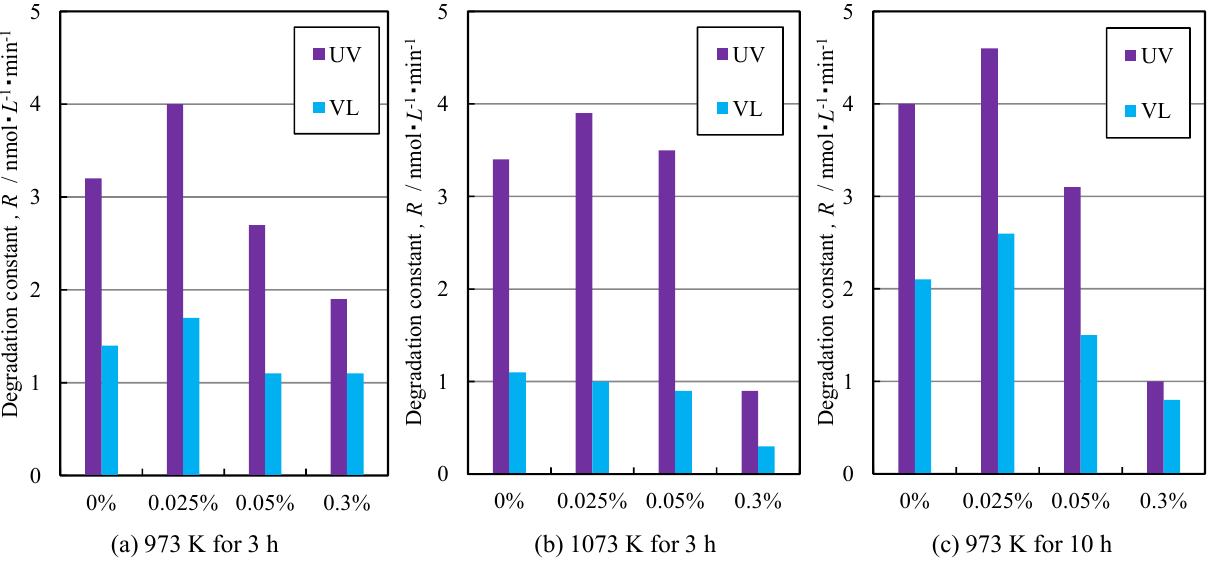
Figure 7. Degradation rate constant of M10- x Cr- y K samples. ( a ) 973 K for 3 h; ( b ) 1073 K for 3 h; ( c ) 973 K for 10